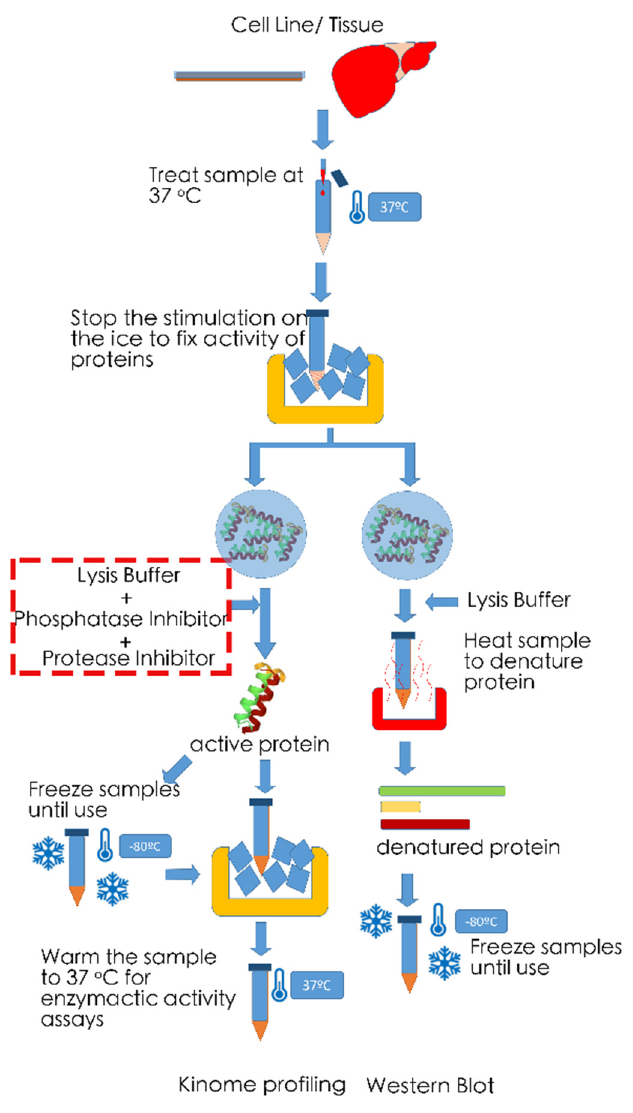
Figure 6. Analysis of native proteins for kinome profiling vs. denatured proteins for Western blot analysis. Kinome profiling can be performed on tissue samples or stimulated/unstimulated cells or cell lines. Placing cells on ice is important to fix the state of phosphorylation and enzymatic activity at the timepoint of interest. While for Western blot analysis samples are reduced and denatured by addition of (for instance) Laemmli buffer and boiling of the samples, proteins generally need to remain in their native state for kinome analysis. Mild lysis in the presence of protease inhibitors is recommended, and samples need to be kept cold at all preparatory steps. In order to reactivate resident enzymes, samples are heated to 37 ◦ C for kinome applications depending on enzymatic activ- ity.